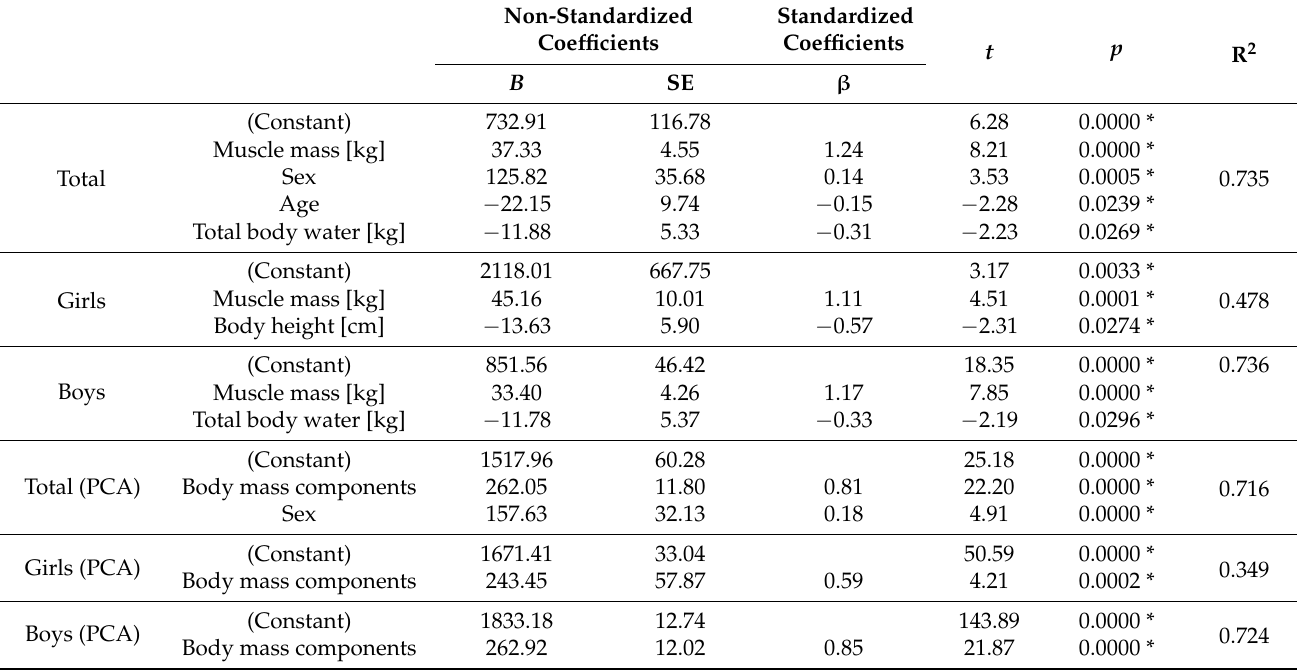
Table 3. The result of general regression model for the selected parameters (independent variables were selected by forward stepwise regression